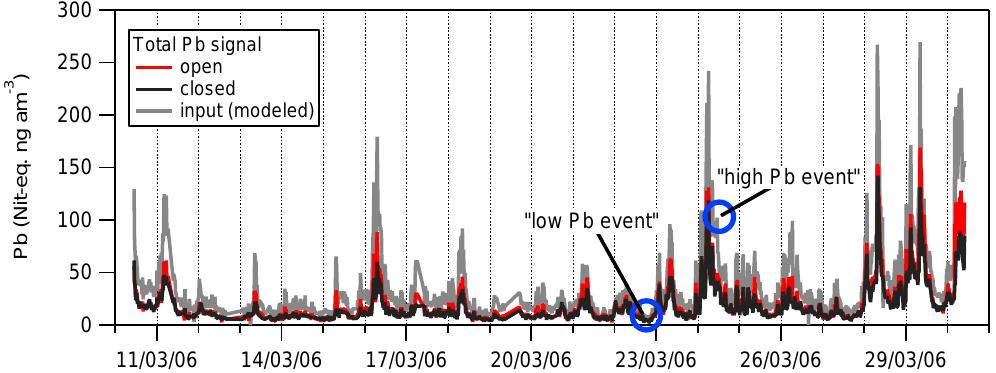
Fig. 6. Time series of open (red line), closed (black line) and calculated total input (grey line) Pb signal for the HR-AMS at T0. Circled periods in blue, correspond to low and high Pb events in Fig. 2.